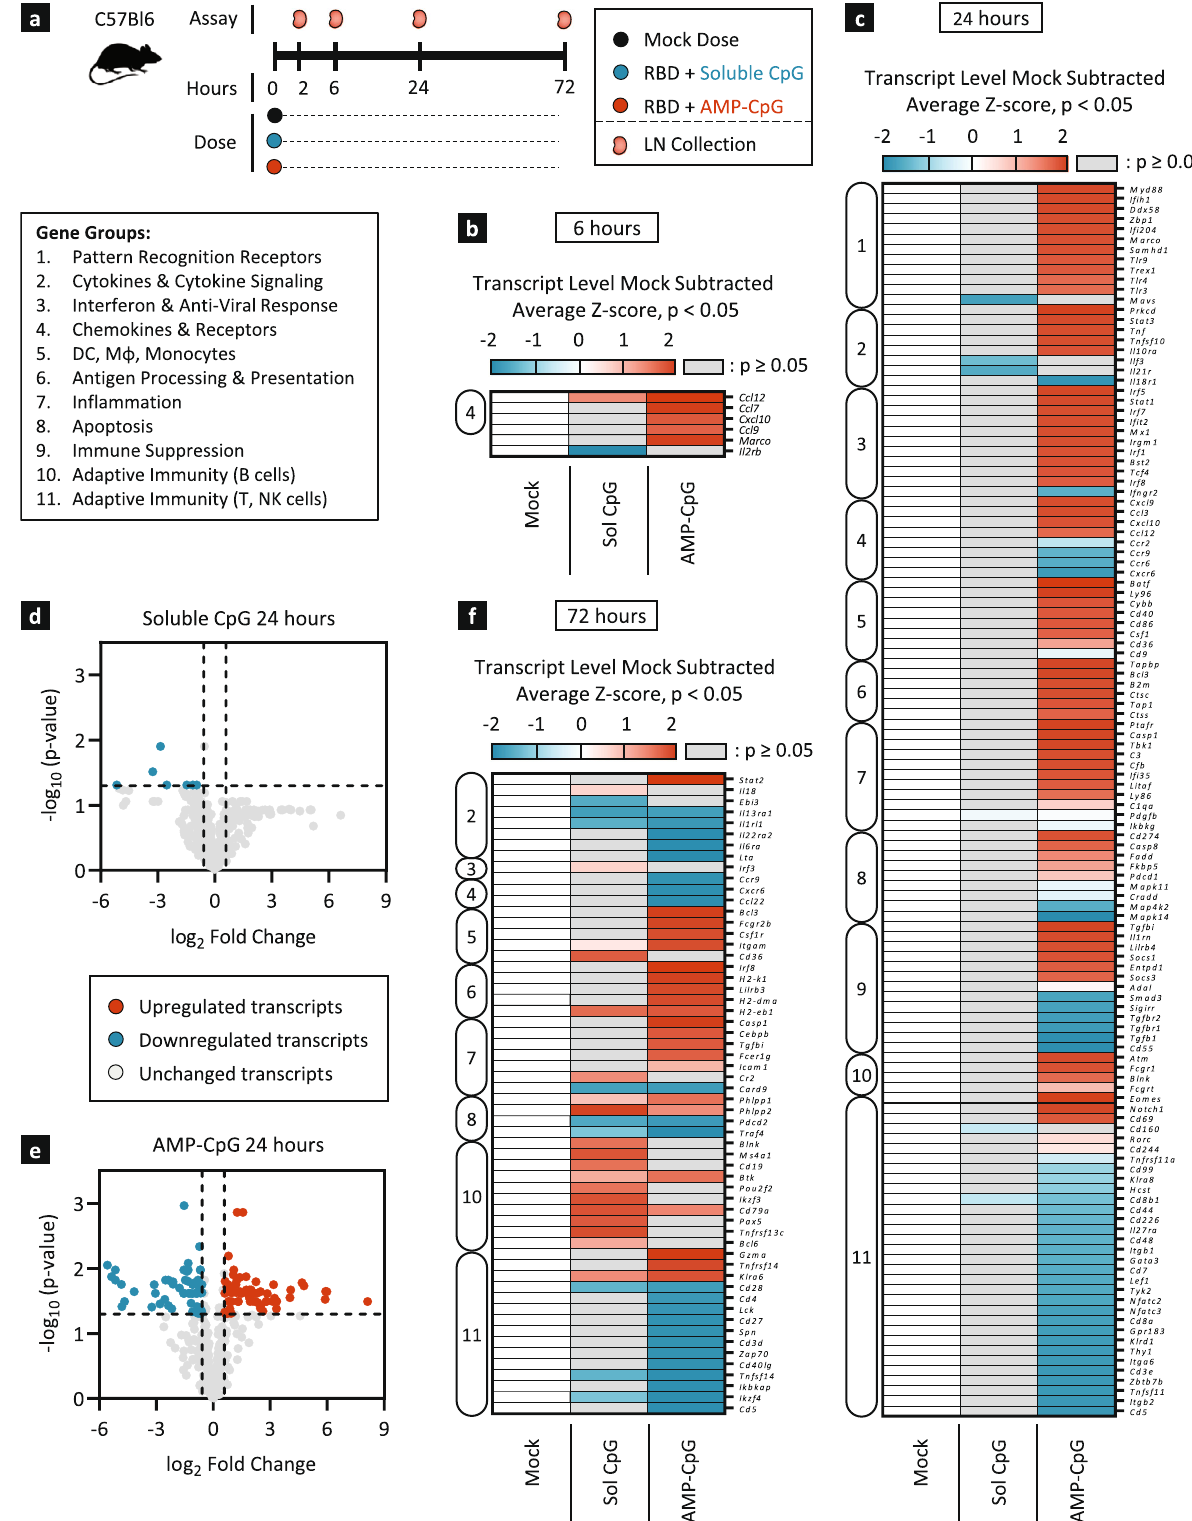
the induced responses was evaluated through stimulation with VOC-speci fi c OLPs, and no signi fi cant differences in the frequency of IFN γ SFC were observed for Beta and Delta OLP stimulation as compared to WH-01 (Fig. 5c), suggesting that ELI-005-induced